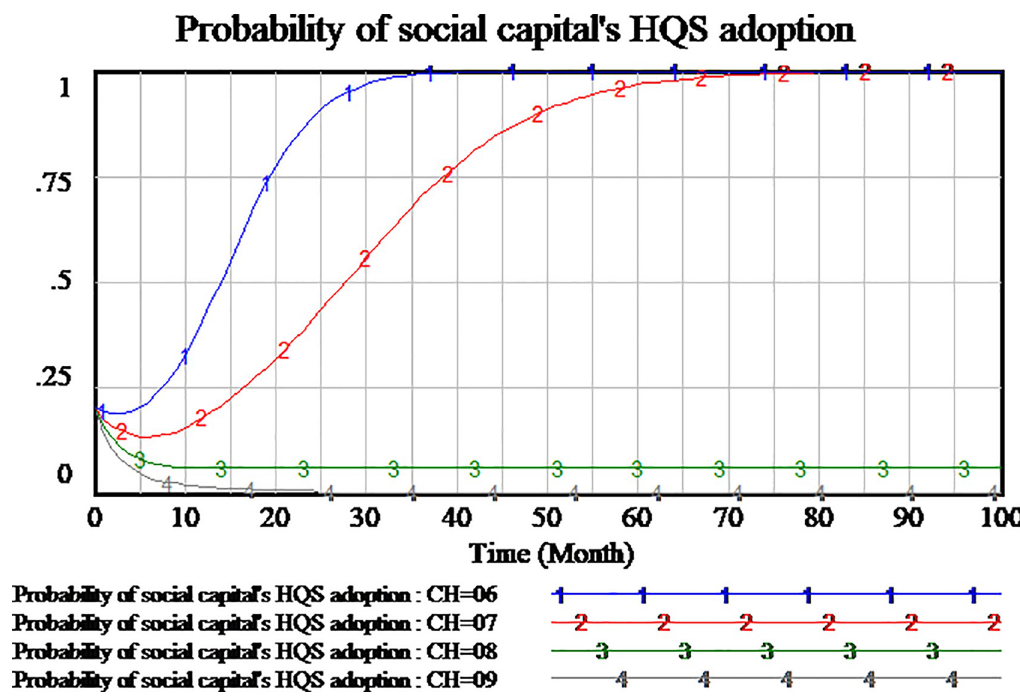
Fig 15. Impact of different cost of high-quality service on social capital.